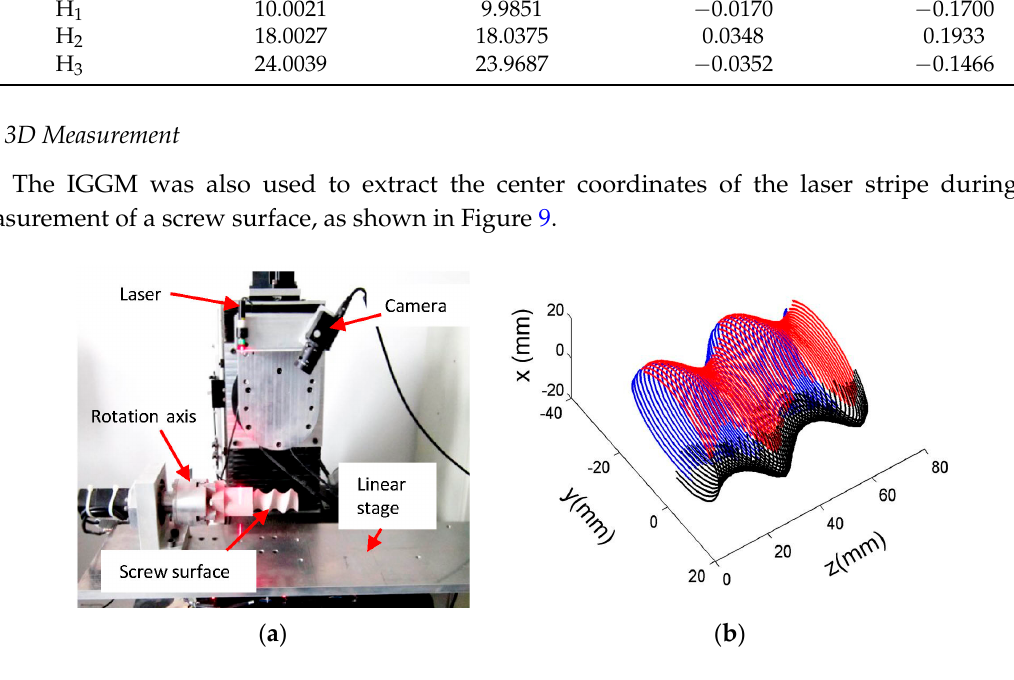
Figure 9. Measuring applications: ( a ) The system setup; ( b ) The measured screw surface.